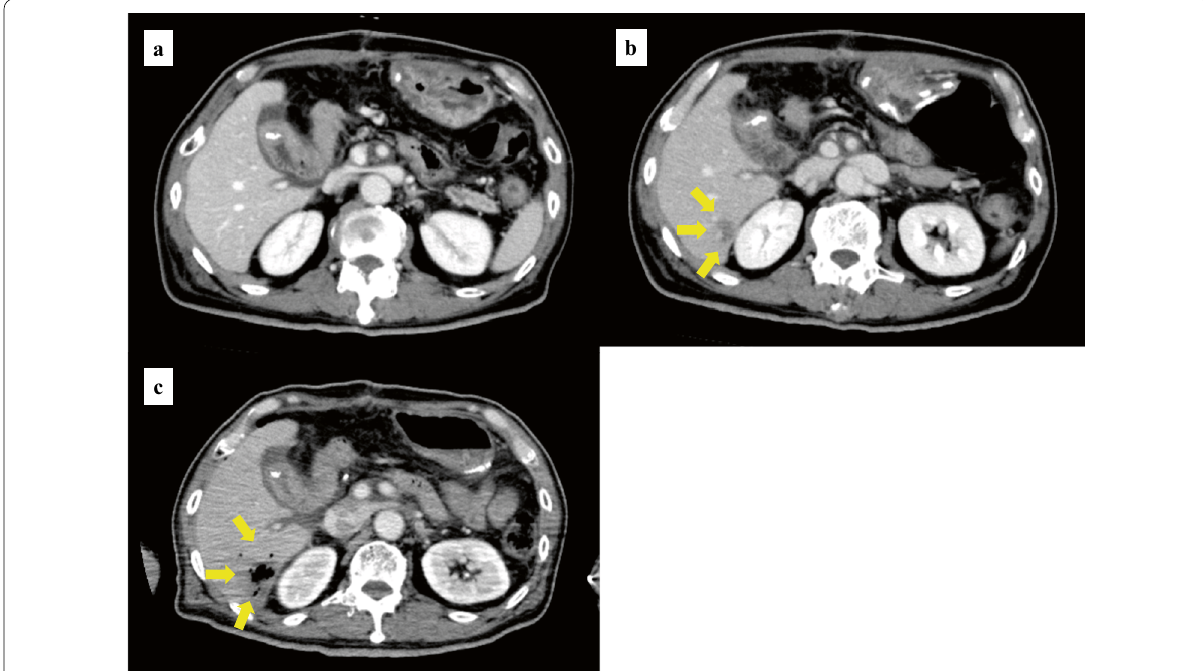
Fig. 1 Computed tomography findings over time. a Postcontrast image showing no abnormal findings on POD 14, 2 days before discharge. b Image obtained when the patient was readmitted on POD18 showing an irregular, 20 mm, low-density area in the S6 region of the liver. c Image obtained 8 h after admission showing that the affected area has transformed into a gas-producing abscess